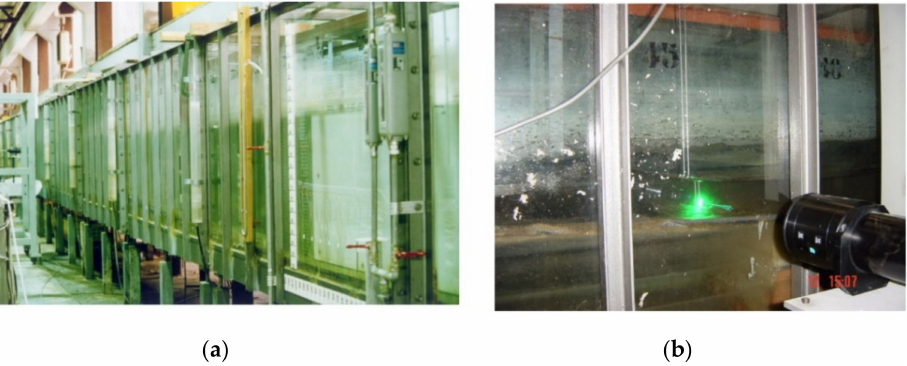
Figure 1. Experimental apparatus: ( a ) a part of the wave channel and ( b ) the LDA probe.